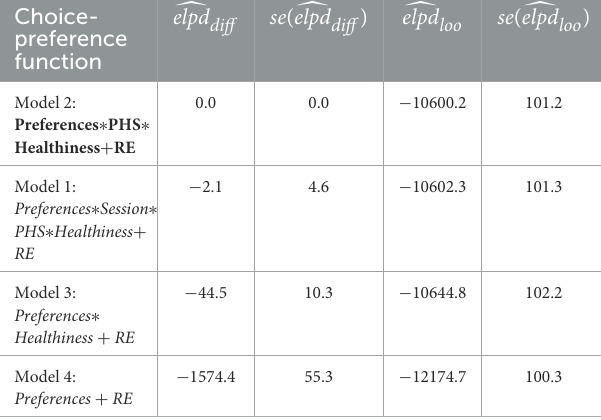
TABLE 3 Fit indices of the choice-preference functions computed by multilevel Bayesian logistic regression linear modeling (ordered by fit). Choice-